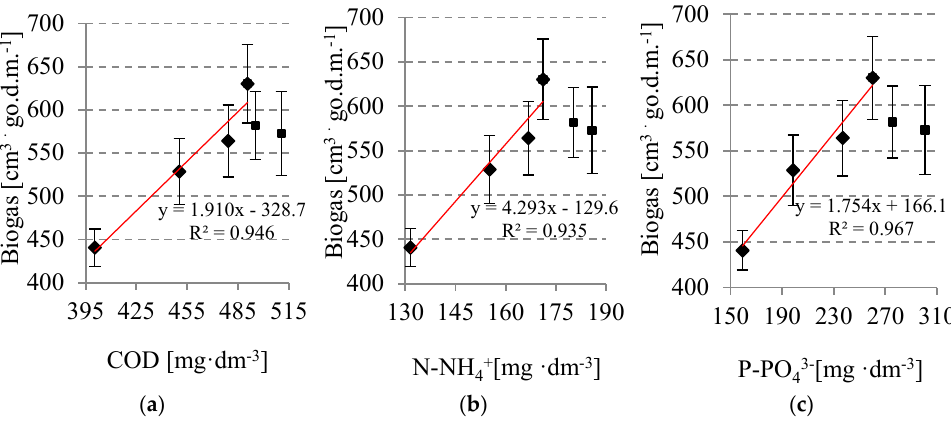
Figure 4. Effect of concentrations of ( a ) chemical oxygen demand (COD), ( b ) N − NH 4+ , and ( c ) P − PO 43 − in the dissolved phase on biogas production.